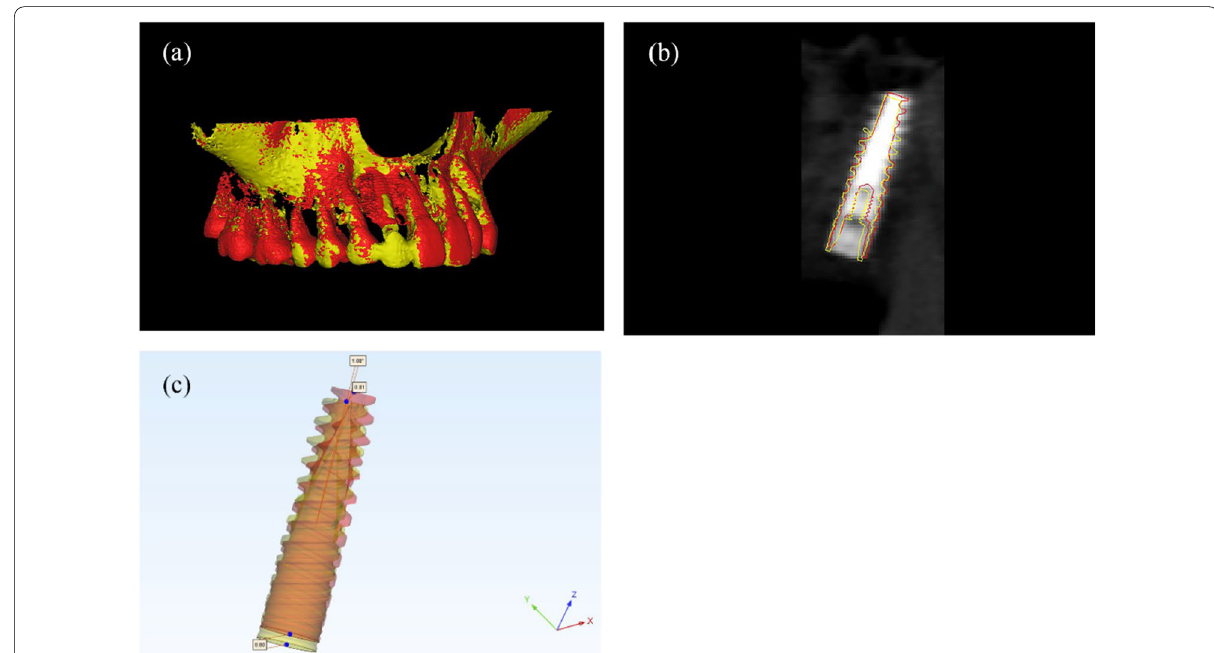
Fig. 4 Measurement procedure. a Registration of the preoperative plan in STL format (colored yellow) and postoperative CBCT (colored red). b Registration of the preoperative implant plan (outlined in yellow) and postoperative implant position (outlined in red). c Measuring angular deviation, coronal, and apical global deviation of planned (colored yellow) and placed (colored red) implant position